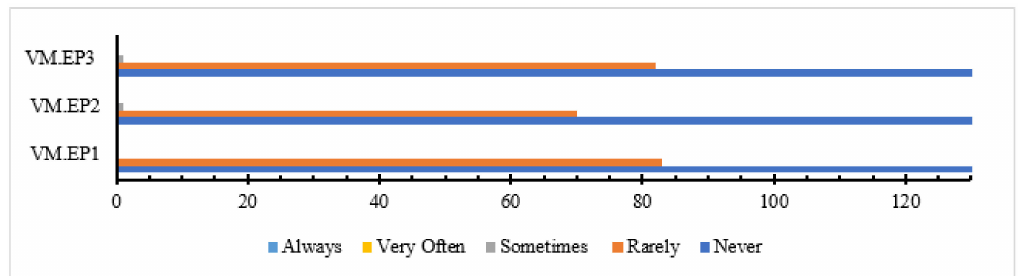
Figure 7. Frequency distribution for the creativity phase.